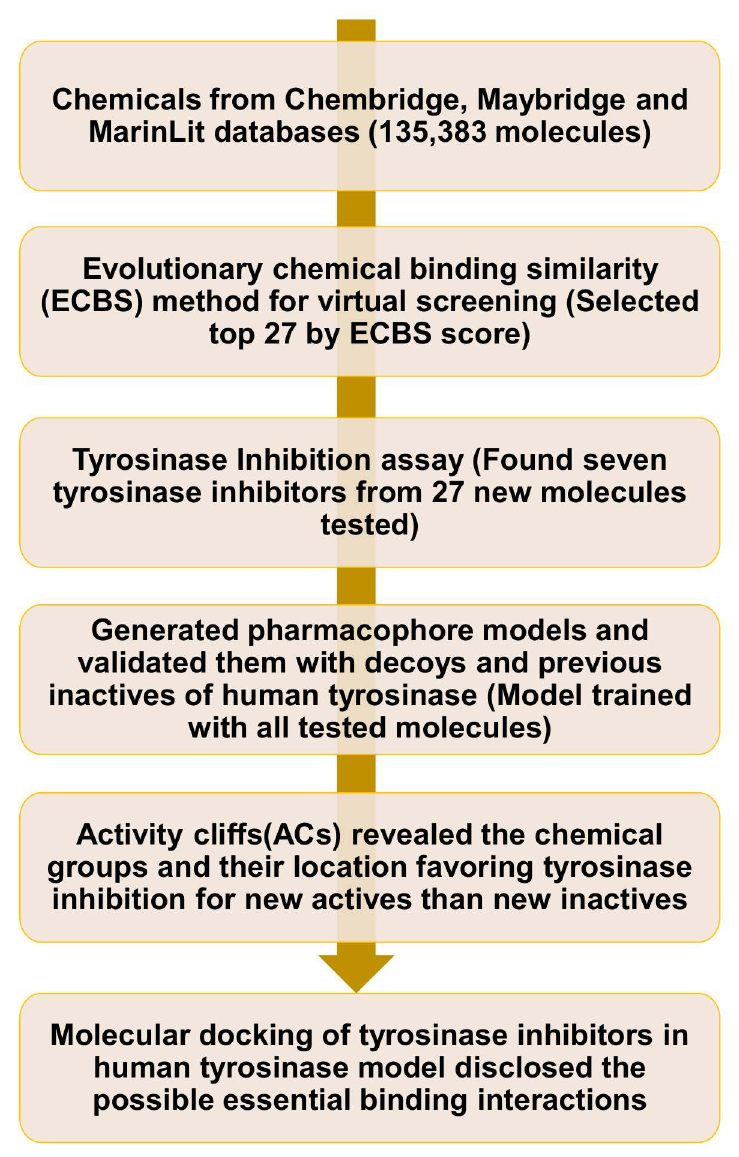
Figure 1. The schematic of the virtual screening procedure followed by pharmacophore modeling, activity cliff analysis, and molecular docking study for tyrosinase